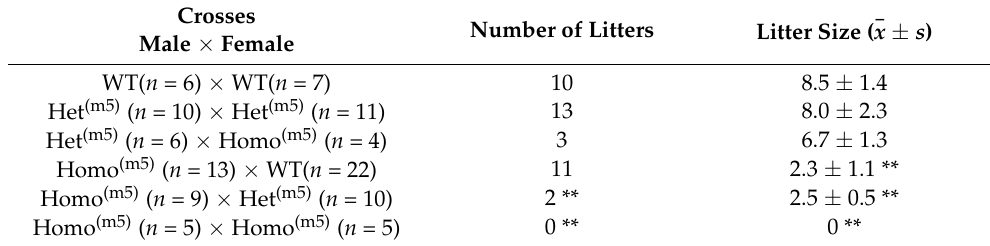
− x ± s , ** p < 0.01). Number of